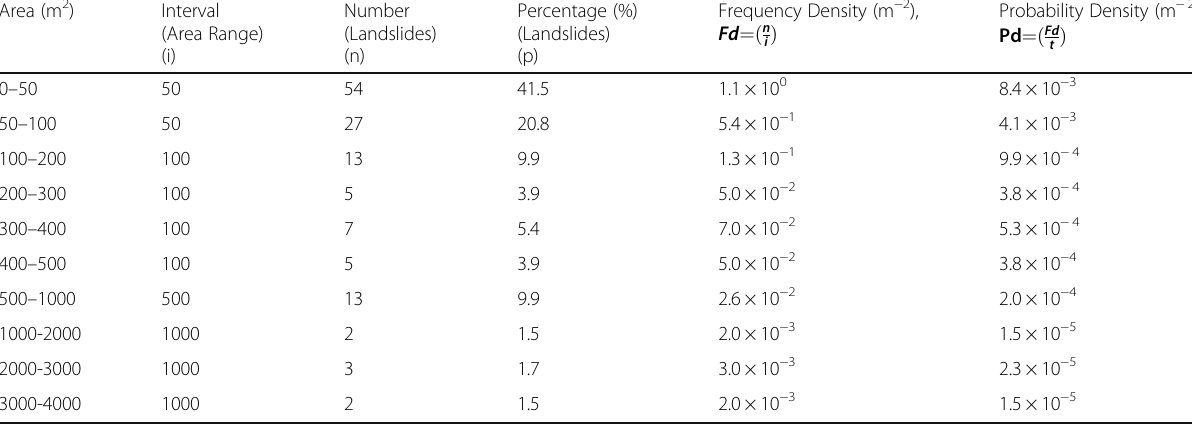
Table 1 Frequency Density and Probability Density of June 2017 Landslides in Rangamati Area (m 2